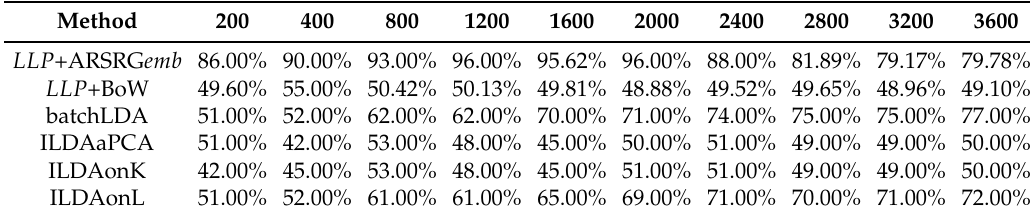
Table 9. Recognition accuracy on the ALOI